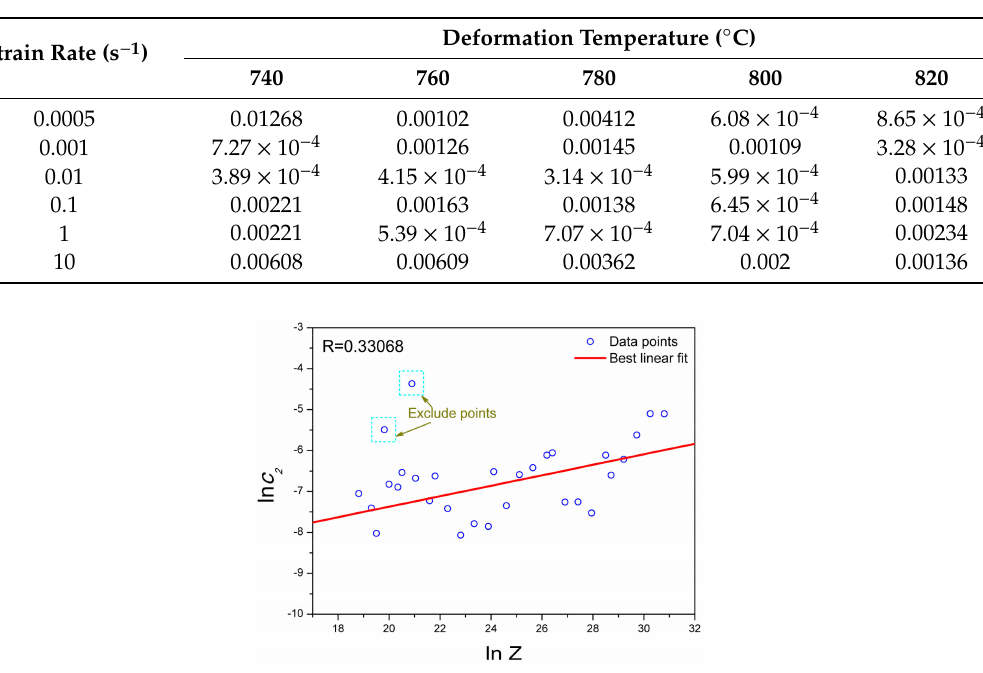
Table 2. The values of the material constant, c 2 , for all of the tested loading combinations.